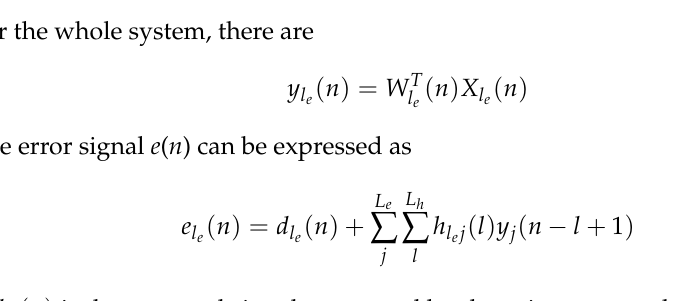
d n is the expected signal, generated by the primary sound source where ( ) e l shown in Figure 2 through primary path response ( n ) is the expected signal, generated by the primary sound source P ( n ) shown where d l l e e ( z ) , W ( n ) is the vector of L -order control R n is the L × L e matrix of the filtered ‐ x signal, formed in Figure 2 through primary path response P l control filter coefficients, and ( ) l e e e l ( n ) is the L × L filter coefficients, and R l e matrix of the filtered- x signal, formed by filtering by filtering reference input signal e ( n ) through response model H (cid:48) ( z reference input signal X l e